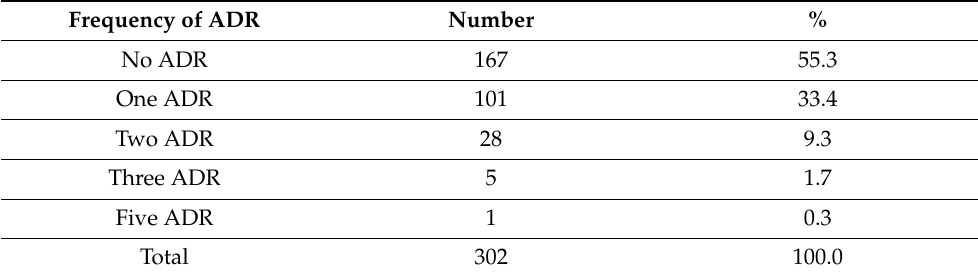
Table 7. Frequency of adverse drug reactions among pediatric tuberculosis patients registered at Tashkent City Children Tuberculosis Hospital and Tashkent Regional Children Tuberculosis Hospital, Uzbekistan, 2019. Frequency of ADR